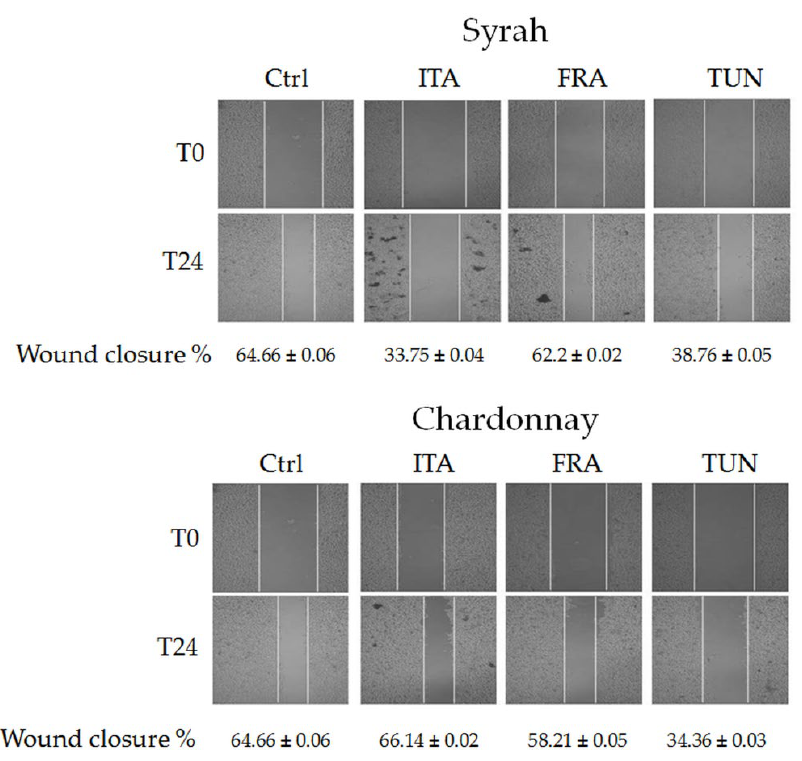
Figure 5. Snapshot microscopy images of wound closure (%) of untreated (Ctrl) and treated with 250 µg/mL of Syrah or Chardonnay from Italy, France, and Tunisia for 24 h B16F10 cells.